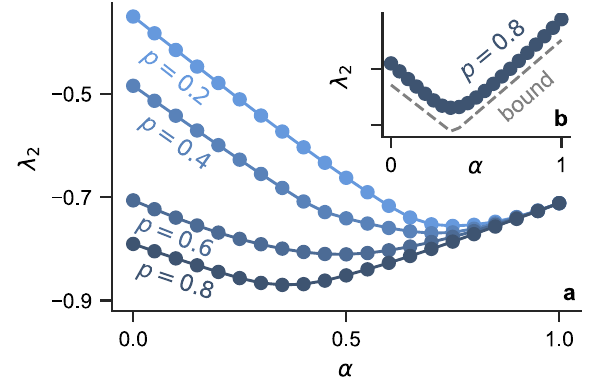
k min n (cid:2) 1